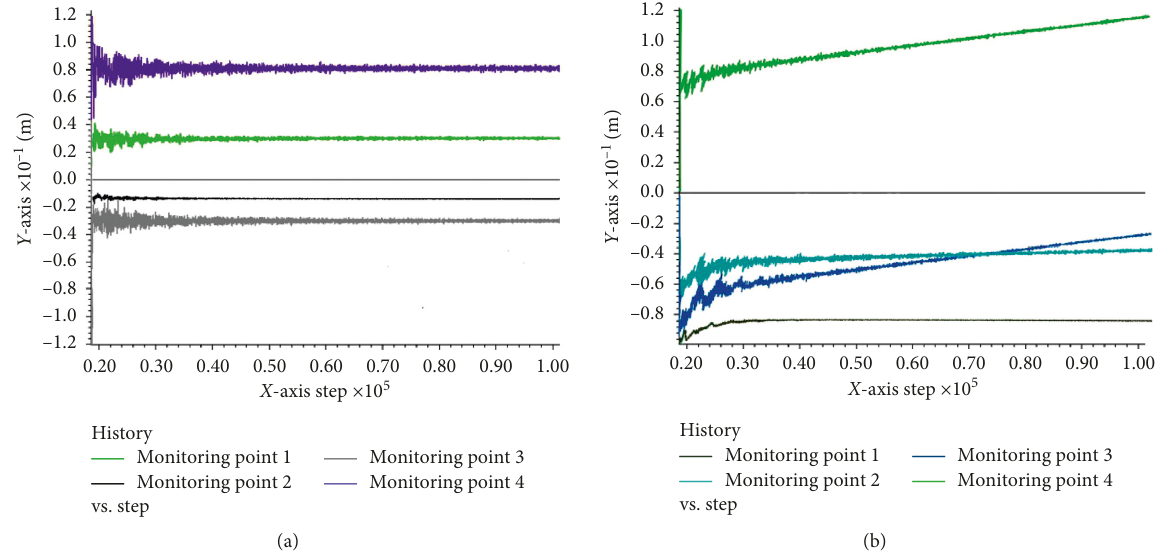
Figure 13: Displacement response diagram for six dynamic loads. (a) X -direction displacement and (b) Z -direction displacement.